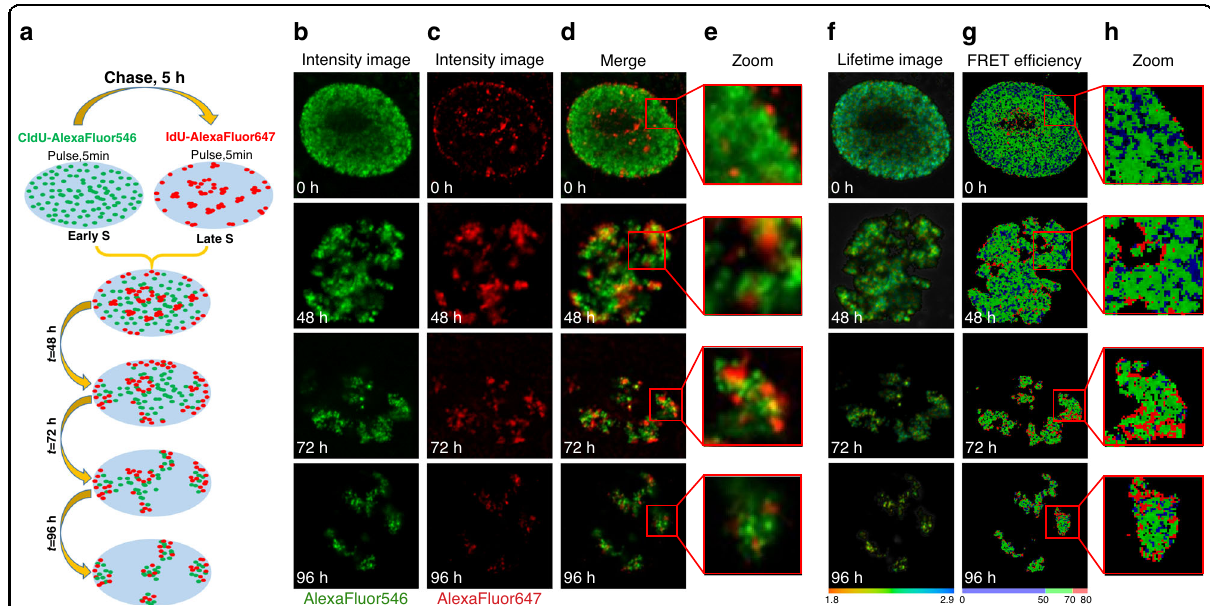
Fig. 5 Simultaneous visualization of early and late S-phase replicating genomic DNA in the same cell nucleus by fl uorescence imaging and the FLIM-FRET approach. a Schematics of approach: cultured cells sequentially labeled with CldU in early S-phase and with IdU in the late S-phase were chased into subsequent cell generations, enabling to visualize segregated chromosome territories with stained early and late S-phase labeled chromatin. b , c Cells were fi xed at various intervals after the halogenated nucleotides pulses and stained for b CldU (AlexaFluor 546, green) and c IdU (AlexaFluor 647, red). Representative fl uorescence intensity ( b – e ), lifetime images ( f ) and FRET ef fi ciency ( g , h ) of the chromosome territories formation process after labeling of the early and late S replicating chromatin domains. Additional representative images are shown at Fig.